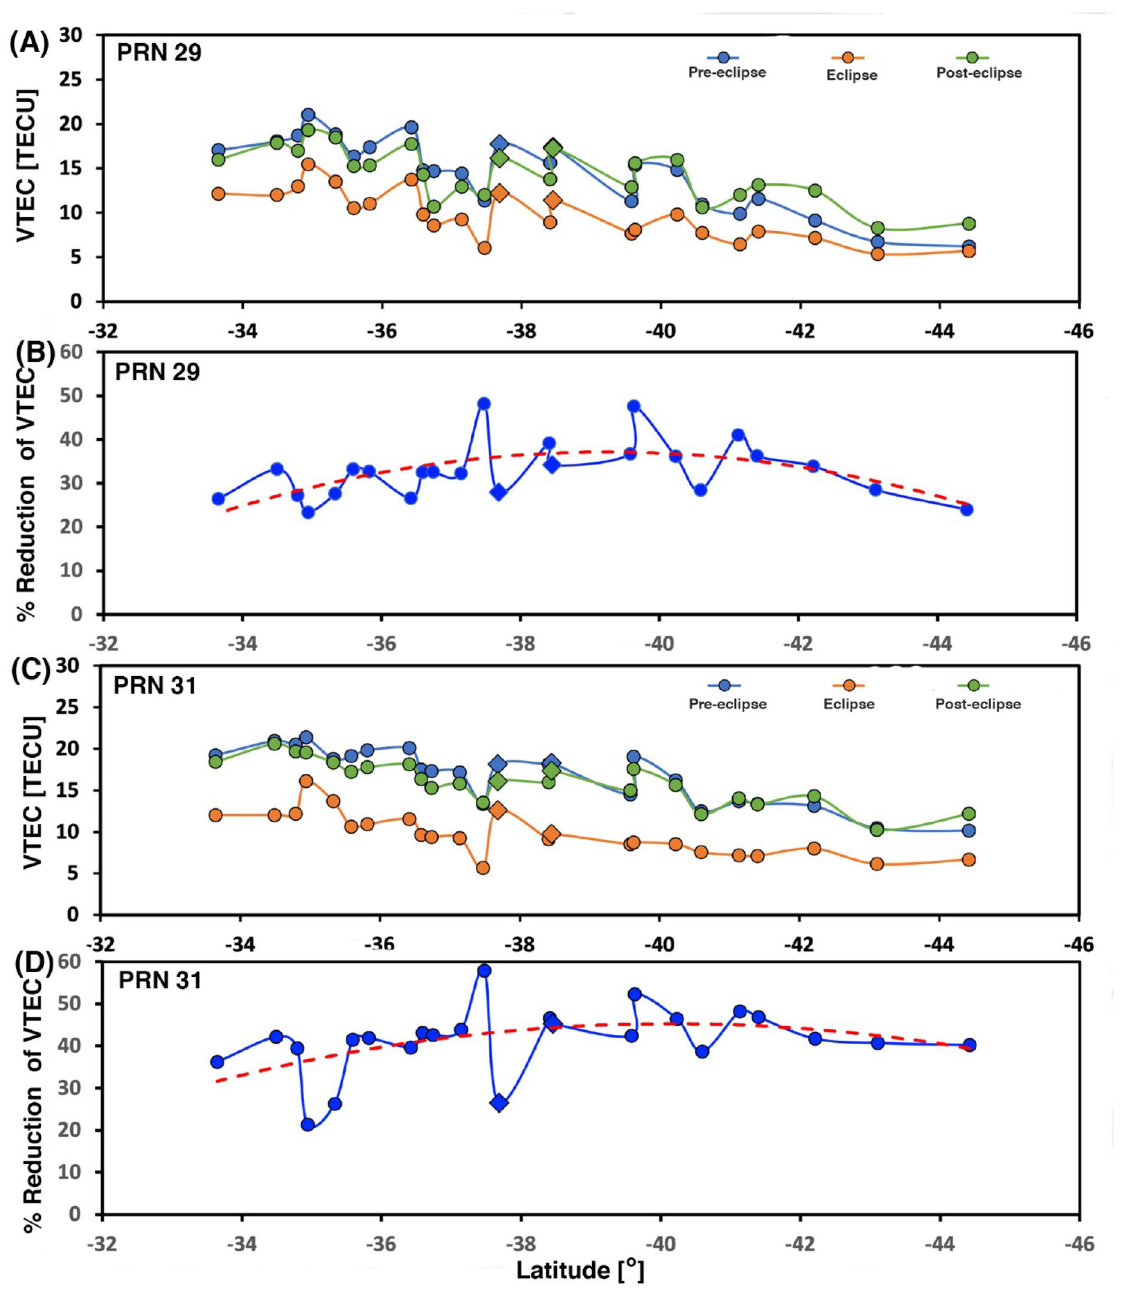
Figure 3. The VTEC of the PRN29 and PRN31 of the GPS sites from the north to south at Total Solar eclipse time, pre-eclipse (DOY, 348), post-eclipse (DOY, 350) and on the eclipse day (DOY, 349) The Figure is prepared using the GMT 5.4.5 37